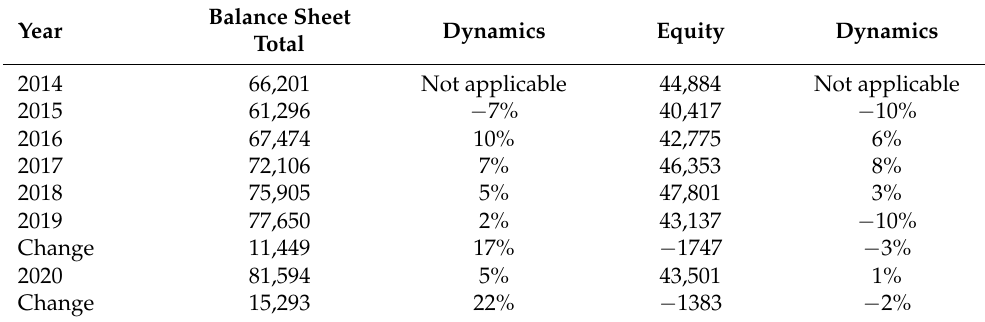
Table 1. Changes in total assets and equity of the PGE Capital Group from 2014 to 2020 (in PLN millions).